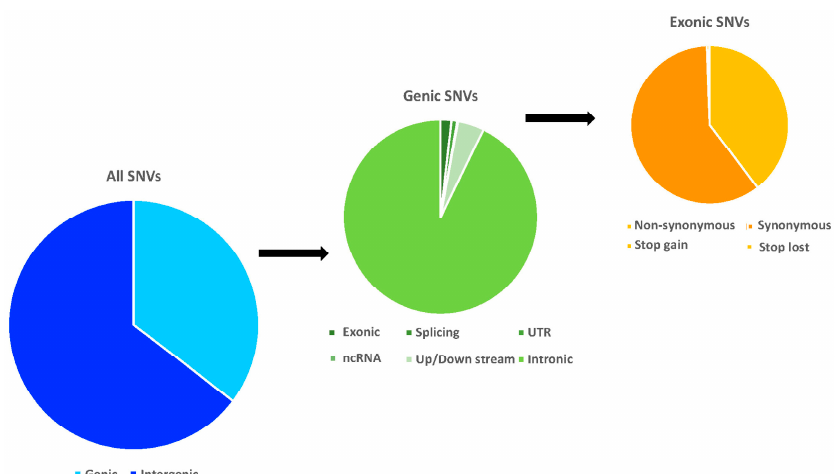
Figure 2. The mean distribution frequencies of the total, genic, and exonic SNVs for all Macaca species structurally annotated based on rhesus macaque genome.